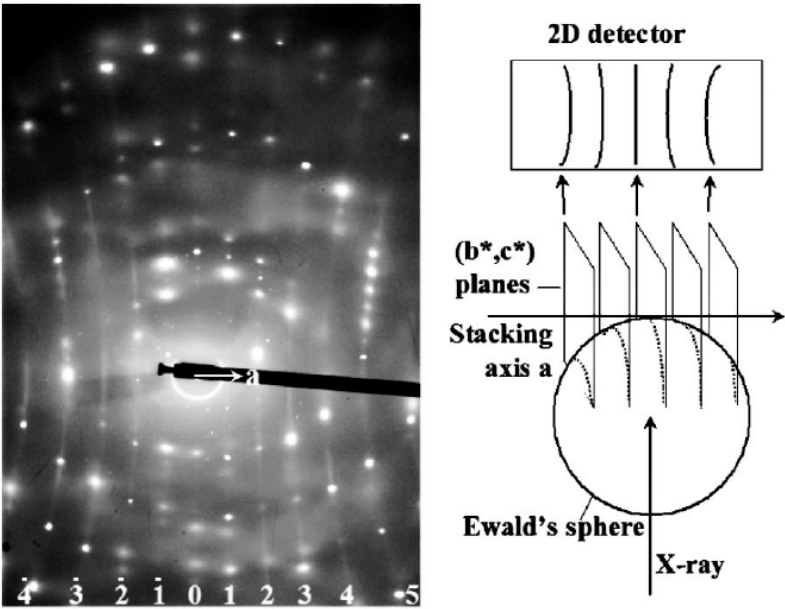
Figure 8. Diffuse planes observed at T NI + 2K (left). The stacking axis a is horizontal and the projections of the intersection of ( b* , c* ) planes with the Ewald sphere correspond to the diffuse curves (right). From Reference [11] with permission. Copyright 2006 American Physical Society.